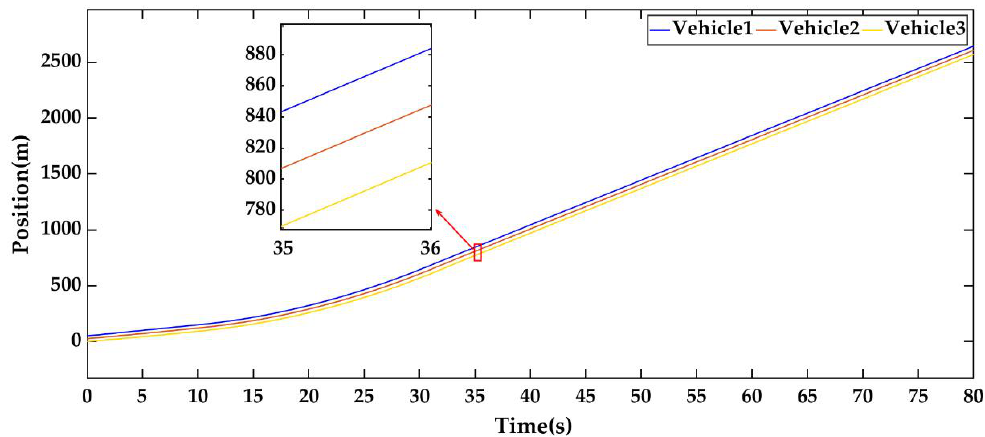
Figure 13. The positions of the following vehicle under the standard MPC strategy in Scenario 1.